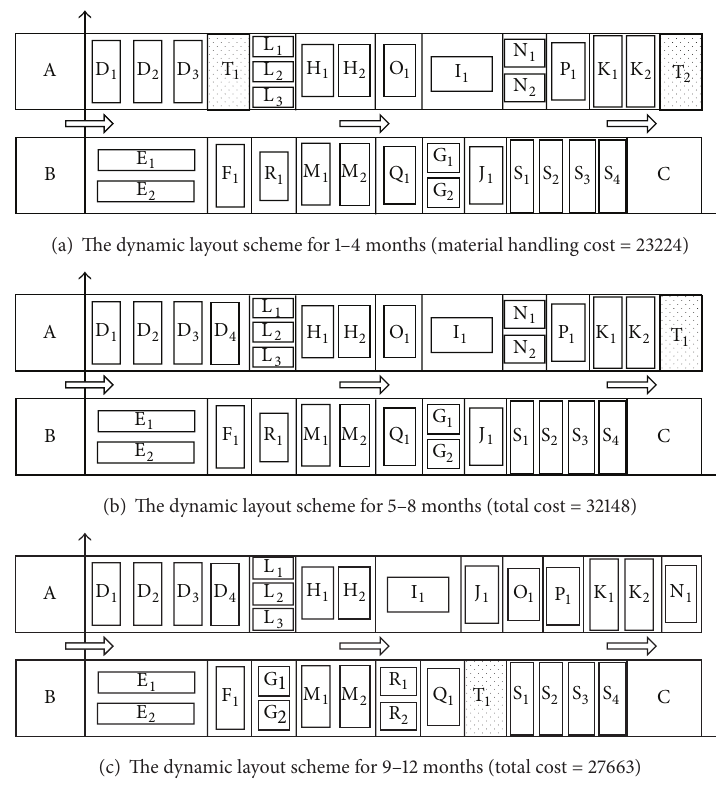
Figure 5: The dynamic layout scheme for a whole year (total cost = 83035).